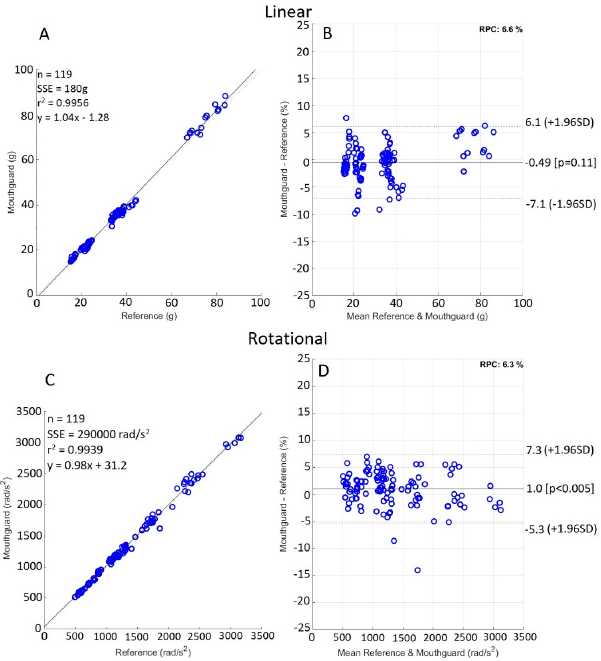
Figure 3. Correlation ( A,C ) and Bland–Altman ( B,D ) plots for PLA and PRA. Figure 4A–D show the ‘Impact’ and ‘Full’ NRMS errors across each impact location. In both cases for LA, one outlier was seen. The associated time-series traces are shown in Figure 6. The two time periods over which the RMS and NRMS were calculated produced different results, with the ‘Full’ RMS producing consistently higher RMS values for both linear and rotational acceleration. Paired-sample t-tests revealed mean differences be- tween the two periods of 0.31 g for LA RMS (t (109 = 5.52, p < 0.05, d = 0.54), –5.50 rad/s 2 for RA RMS (t (109) = 1.65, p = 0.10, d = 0.18), -0.85% for LA NRMS (t (109) = 5.88, p < 0.05, d = 0.56), and 0.41% for RA NRMS (t (109 ) = 3.01, p < 0.05, d = 0.3). Figure 4 shows that there was no visible increase in the NRMS as the PLA increased. Additionally, the NRMS showed no relationship with impact duration.